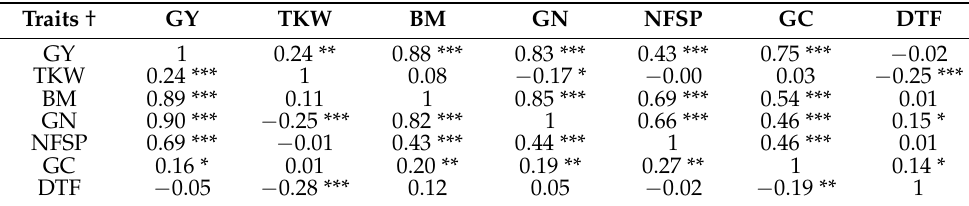
Table 1. Pearson’s correlation among traits at Taoujdate (below diagonal) and Sidi El Aidi (above diagonal) experimental stations.